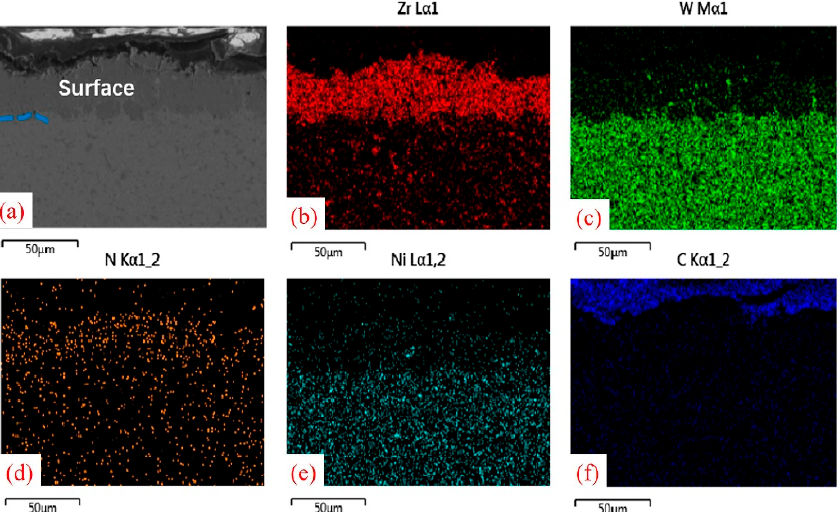
Figure 2. Microstructure and EDS element mapping of FC5-2, ( a ) microstructure, and ( b – f ) respec- tive element mappings of Zr, W, Co, N, and C.